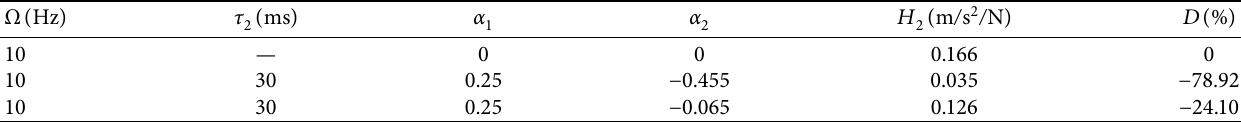
� 0 . 25, and τ � 30 1 2